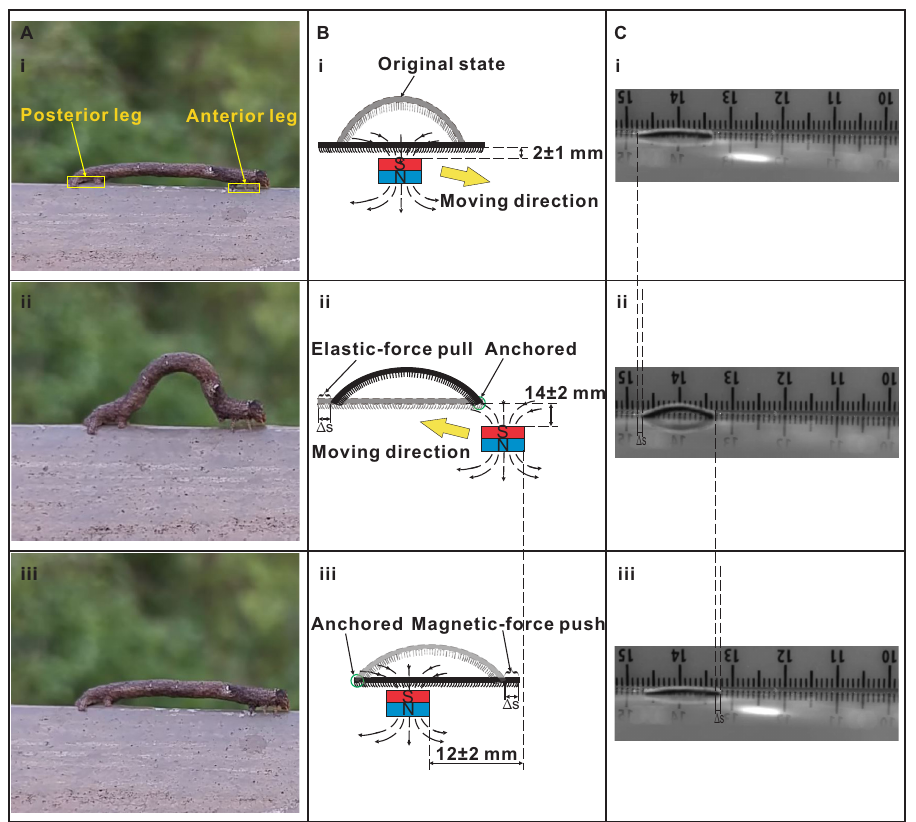
Figure 2. Illustration of inchworm robot locomotion. ( A ) Biological inchworm locomotion in a looping gait. ( i ) Initial position of the inchworm. ( ii ) The inchworm anchors its anterior leg and pulls its posterior leg moving forward. ( iii ) The inchworm anchors its posterior leg and pushes its anterior leg going forward. ( B ) Schematic diagram of motion decomposition of magnetic inchworm robot, and the gray shape and the black shape are undeformed and deformed shapes, respectively. ( i ) Permanent magnet is located below the curved magnetic inchworm robot ( ∼ 2 mm in vertical distance), and the attractive magnetic force makes it flatten. ( ii ) The magnet moves to the lower right ( ∼ 14 mm in vertical distance), and the magnetic attraction will anchor the anterior leg, and the pre-load elastic muscle will contract to pull the posterior leg moving forward. ( iii ) The magnet moves to the upper left ( ∼ 12 mm in horizontal distance), closer to the posterior leg, and the magnetic attraction will anchor the posterior leg and meanwhile attract the magnetic body to become flat, pushing the anterior leg forward. ( C ) Locomotion of fabricated magnetic inchworm robot. Locomotion in ( i – iii ) correspond to those in ( B ( i )–( iii